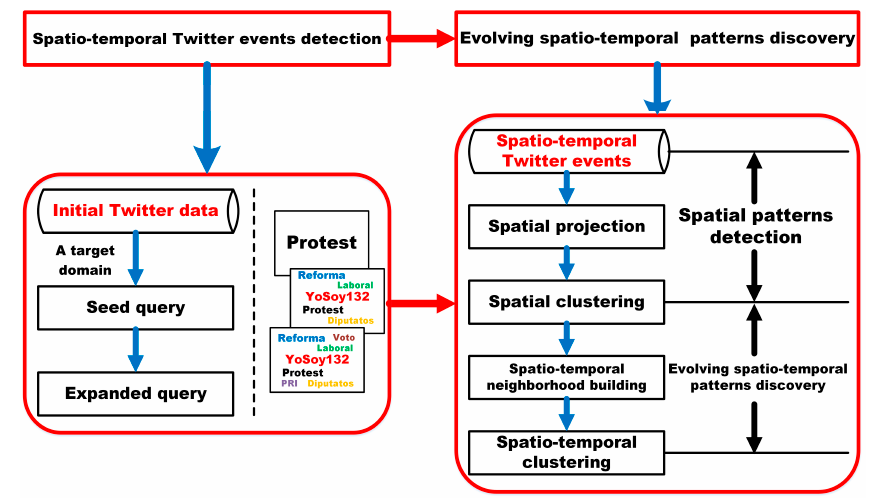
Figure 3. The proposed framework for discovering evolving patterns in geo-tagged Twitter events.